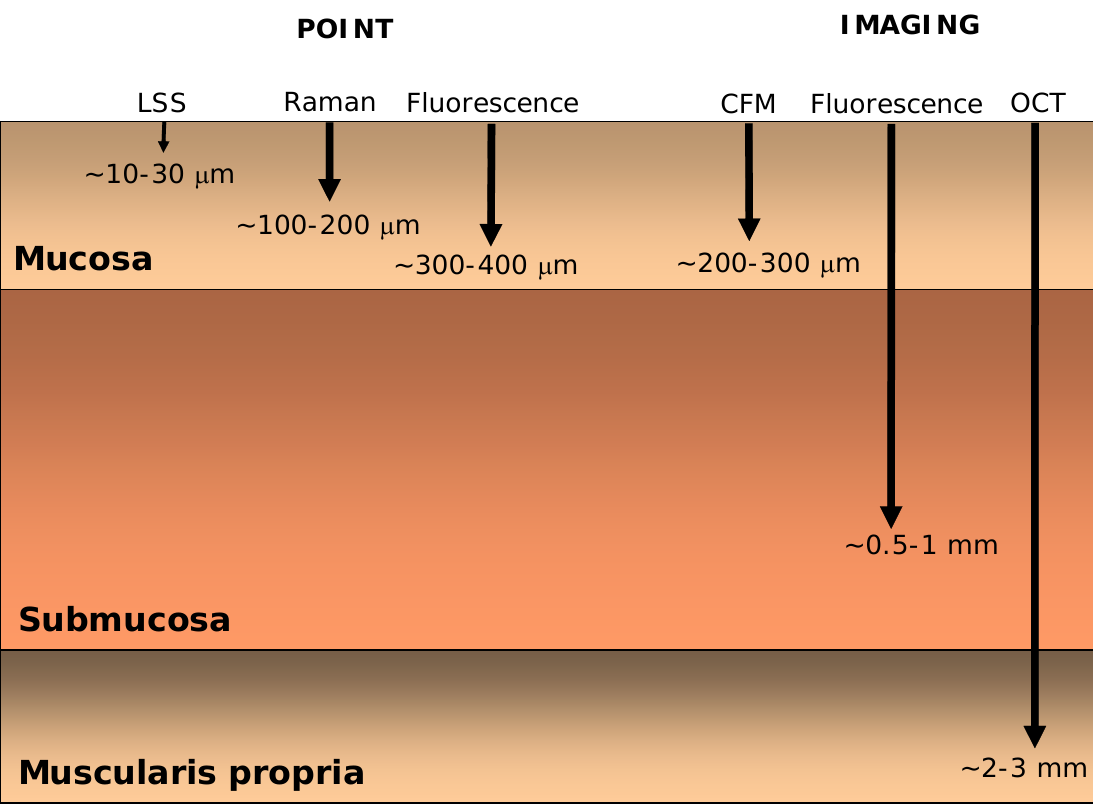
FIGURE 2. Relative comparison between effective tissue sampling depths of point and wide-field imaging